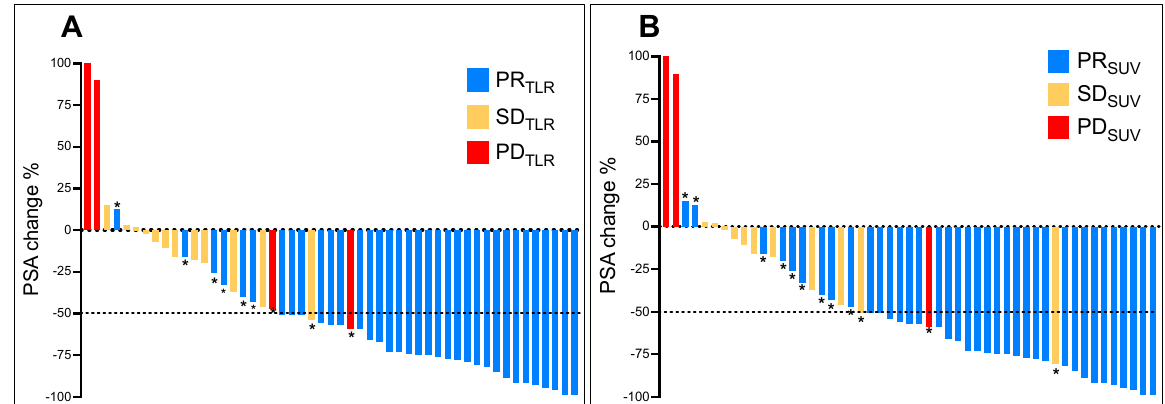
Figure 3. Waterfall plots illustrating the relative changes in standard biochemical parameters (PSA) after two cycles of 177 Lu-PSMA-617 RLT compared to the assessment in molecular-imaging based response with TLR ( A ) and SUV ( B ). Values marked with * highlight the discordant cases.